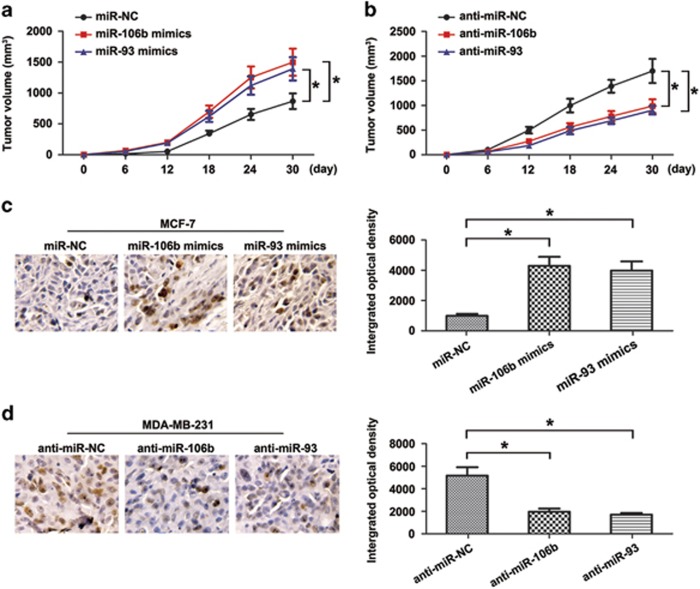
Upregulation of miR-106b or miR-93 promoted the proliferative capacity of breast cancer in vivo. (a-d) MCF-7 and MDA-MB-231 cells were subcutaneously implanted into the right flank of each nude mouse to form tumors. When bearing palpable tumors, the mice were injected intratumorally with miR-106b mimics, miR-93 mimics, anti-miR-106b or anti-miR-93 and their negative controls three times per week for 4 weeks. (a and b) The growth curve of tumor tissues was measured every 6 days. (cand d) The expression of Ki67 in tumor tissues was tested by IHC analysis. Each experiment was independently repeated at least three times. Data were presented as mean±S.D. (*P<0.05)